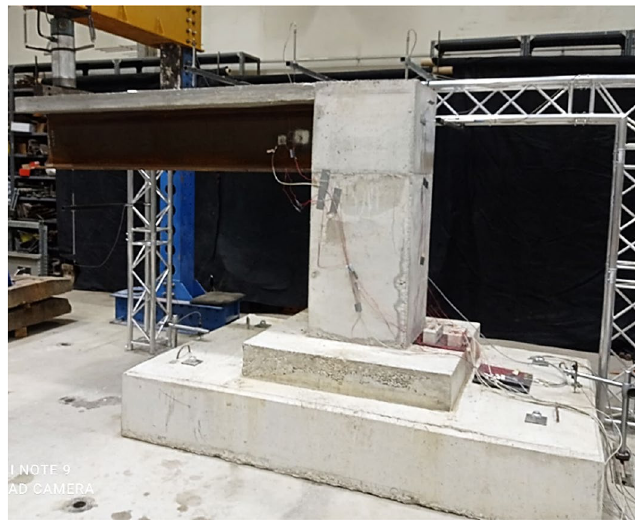
Figure 6. Composite integral abutment bridge structure set up.